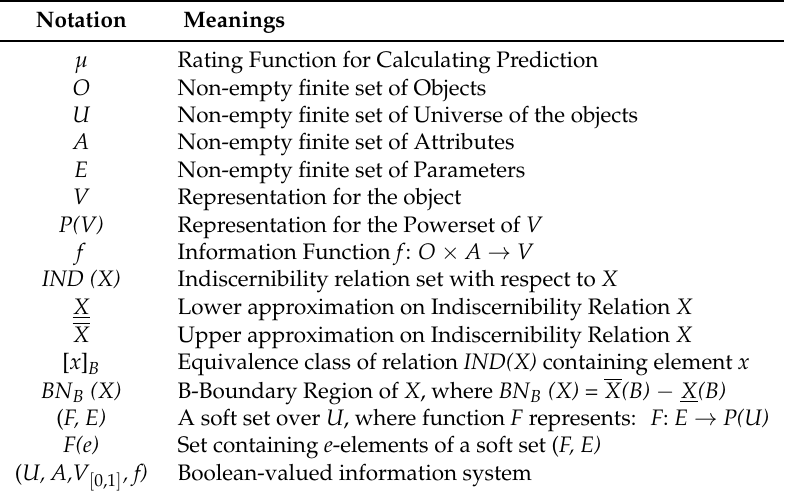
Table 2. Major notations used with their